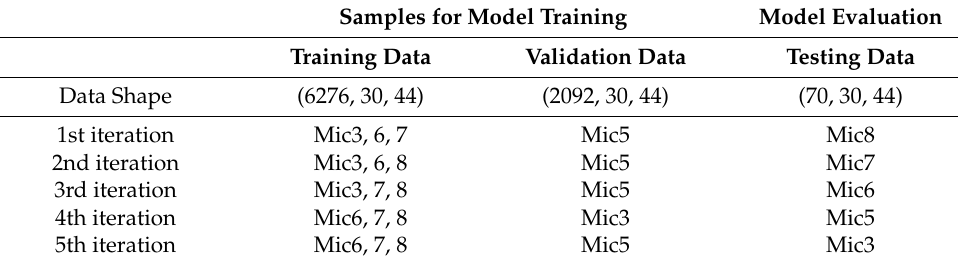
Table 5. Leave-one-subject-out cross-validation (n_steps = 30).